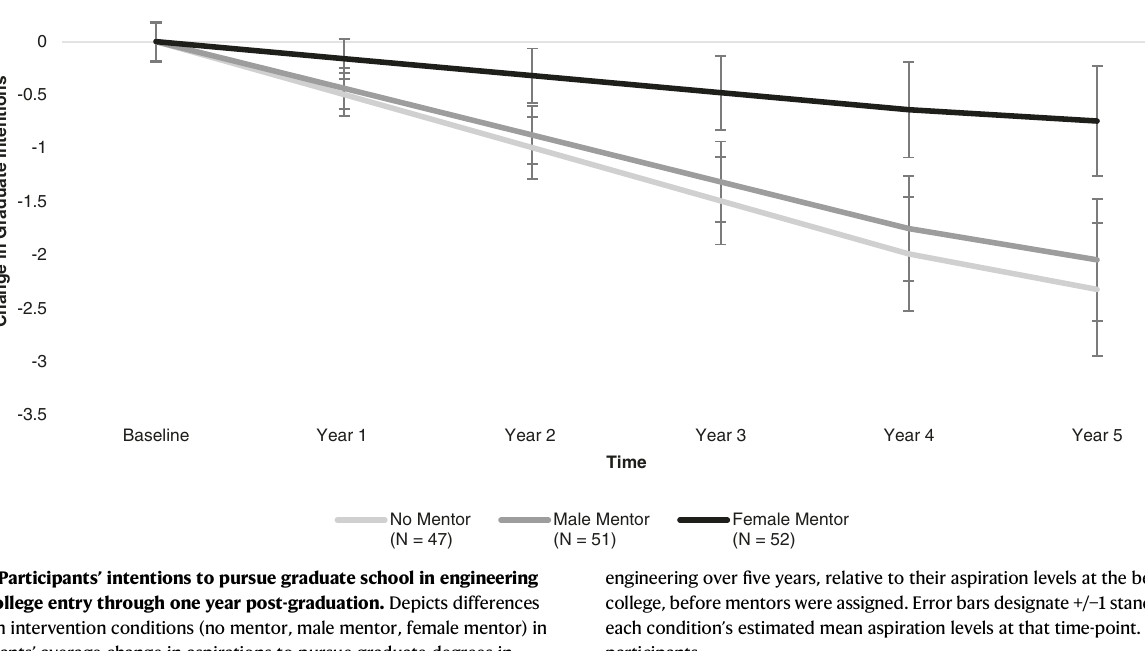
Fig. 3 | Participants ’ intentions to pursue graduate school in engineering from college entry through one year post-graduation. Depicts differences between intervention conditions (no mentor, male mentor, female mentor) in participants ’ average change in aspirations to pursue graduate degrees in